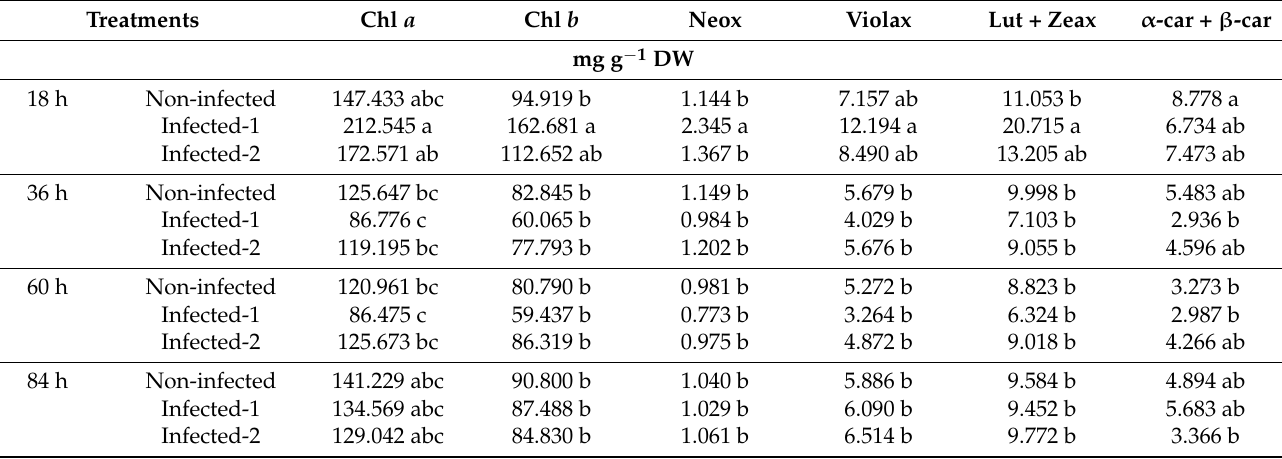
Table 7. Chlorophylls and carotenoids measurements of “Little Gem” lettuce after 12, 18, 36, 60, and 84 h of artificial